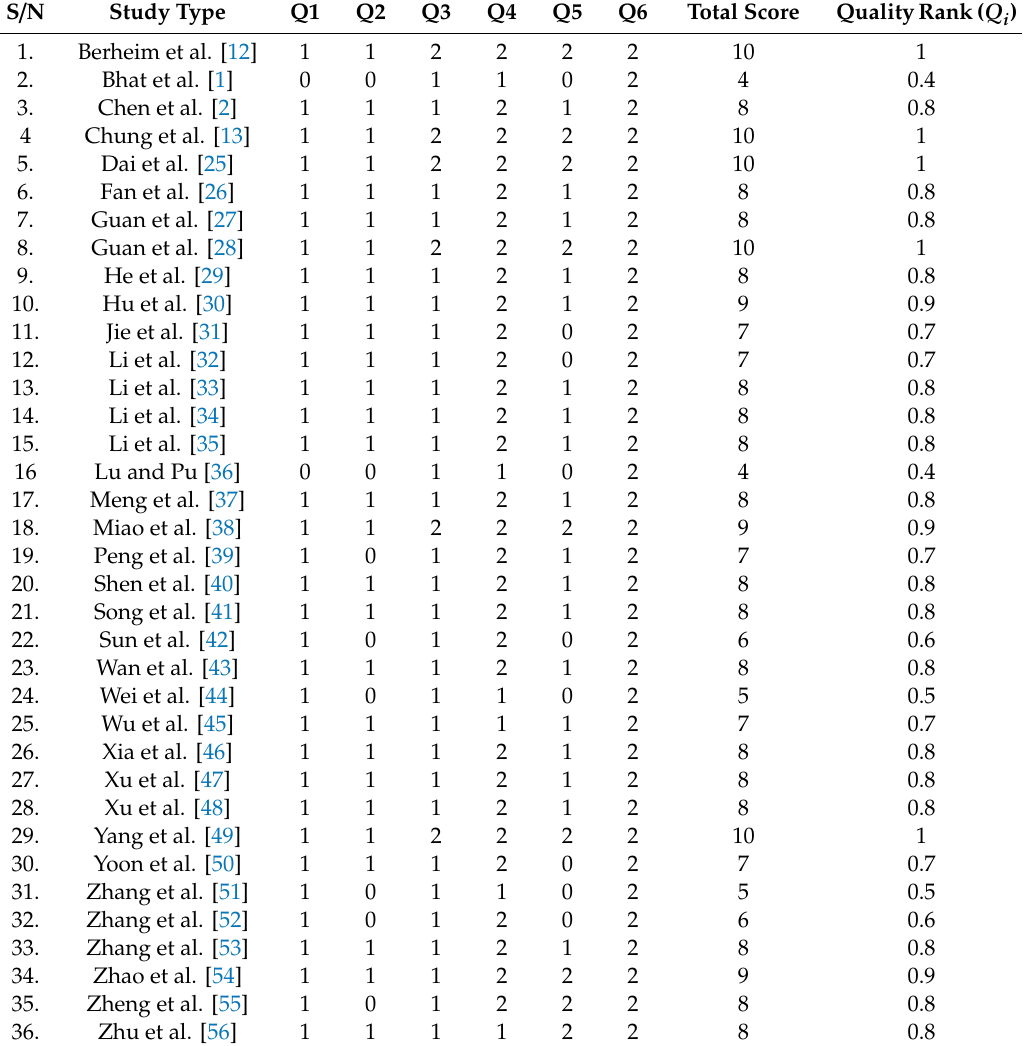
Table A2. Estimation of rescaled quality rank for 36 eligible